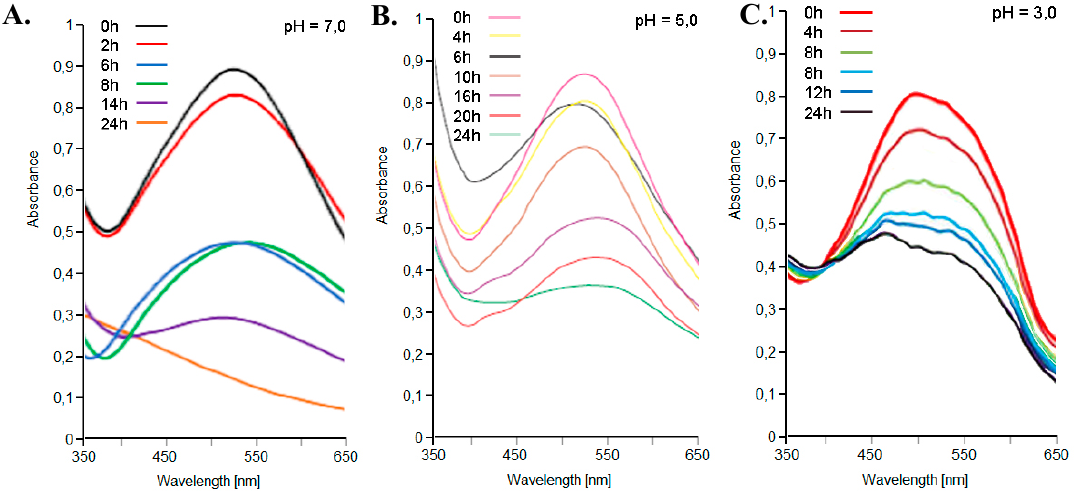
Figure 6. UV-VIS spectra, between 350–650 nm, of the red-violet peels from the Opuntia ficus-indica (L.) Miller extracts with the Extractor Naviglio ® in water solvent, stored at 4 °C and different pH values: 7.0 (A), 5.0 (B) and 3.0 (C).